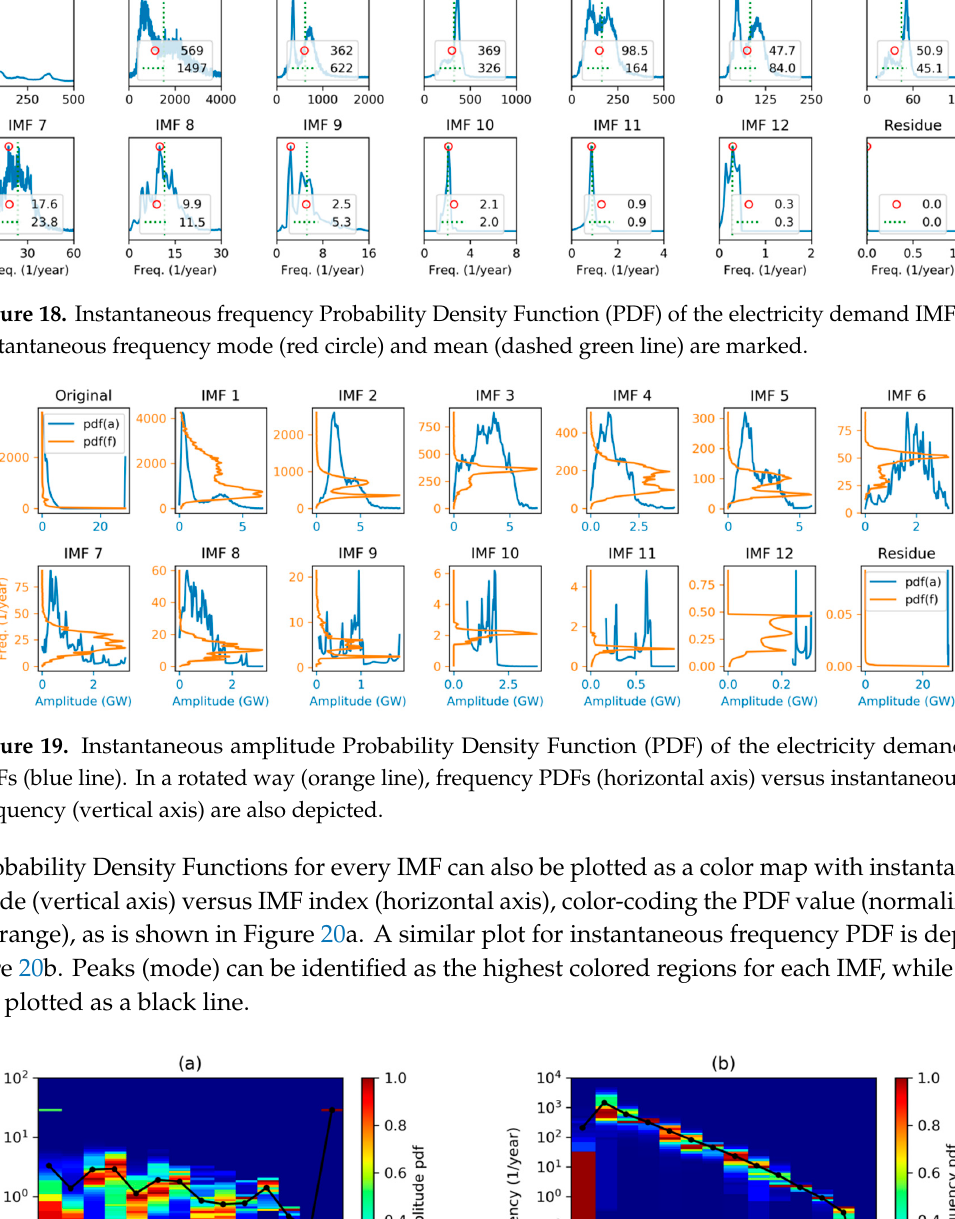
Figure 20. Statistical analysis (probability density function) of the electricity demand IMFs Hilbert Spectra: ( a ) Instantaneous amplitude; ( b ) instantaneous frequency. Black line shows the statistical mean. Previous statistical analyses consider instantaneous amplitude and frequency as two independent variables, but this is not really the case. Extending the PDF concept to the full Hilbert Spectrum considered as a 2-dimensional random process 𝑆(𝑛) = (cid:4670)𝕒(𝑛), 𝕗(𝑛)(cid:4671) , a joint PDF can be obtained, and the results for each IMF are shown in Figure 21. They are plotted color-coding the logarithm of the joint PDF (normalized in the 0–1 range) as a function of the instantaneous amplitude (horizontal axis) and frequency (vertical axis). The mean value (cid:4670)𝜇 𝕒 , 𝜇 𝕗 (cid:4671) is marked with a black cross.